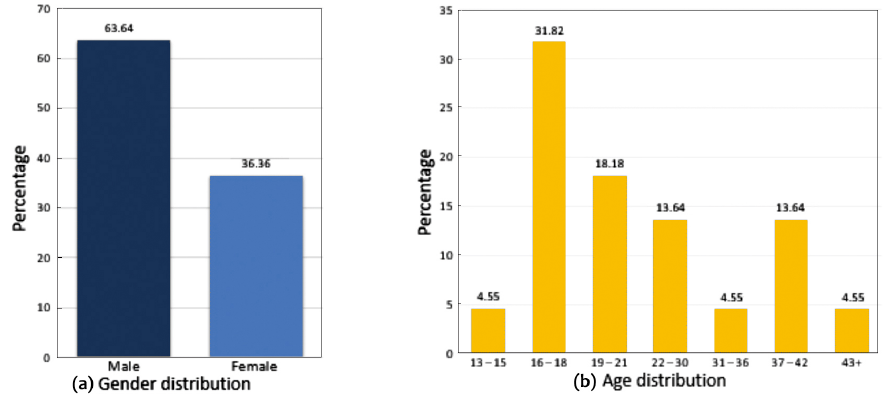
Fig. 3 Demographic distribution of study participants.